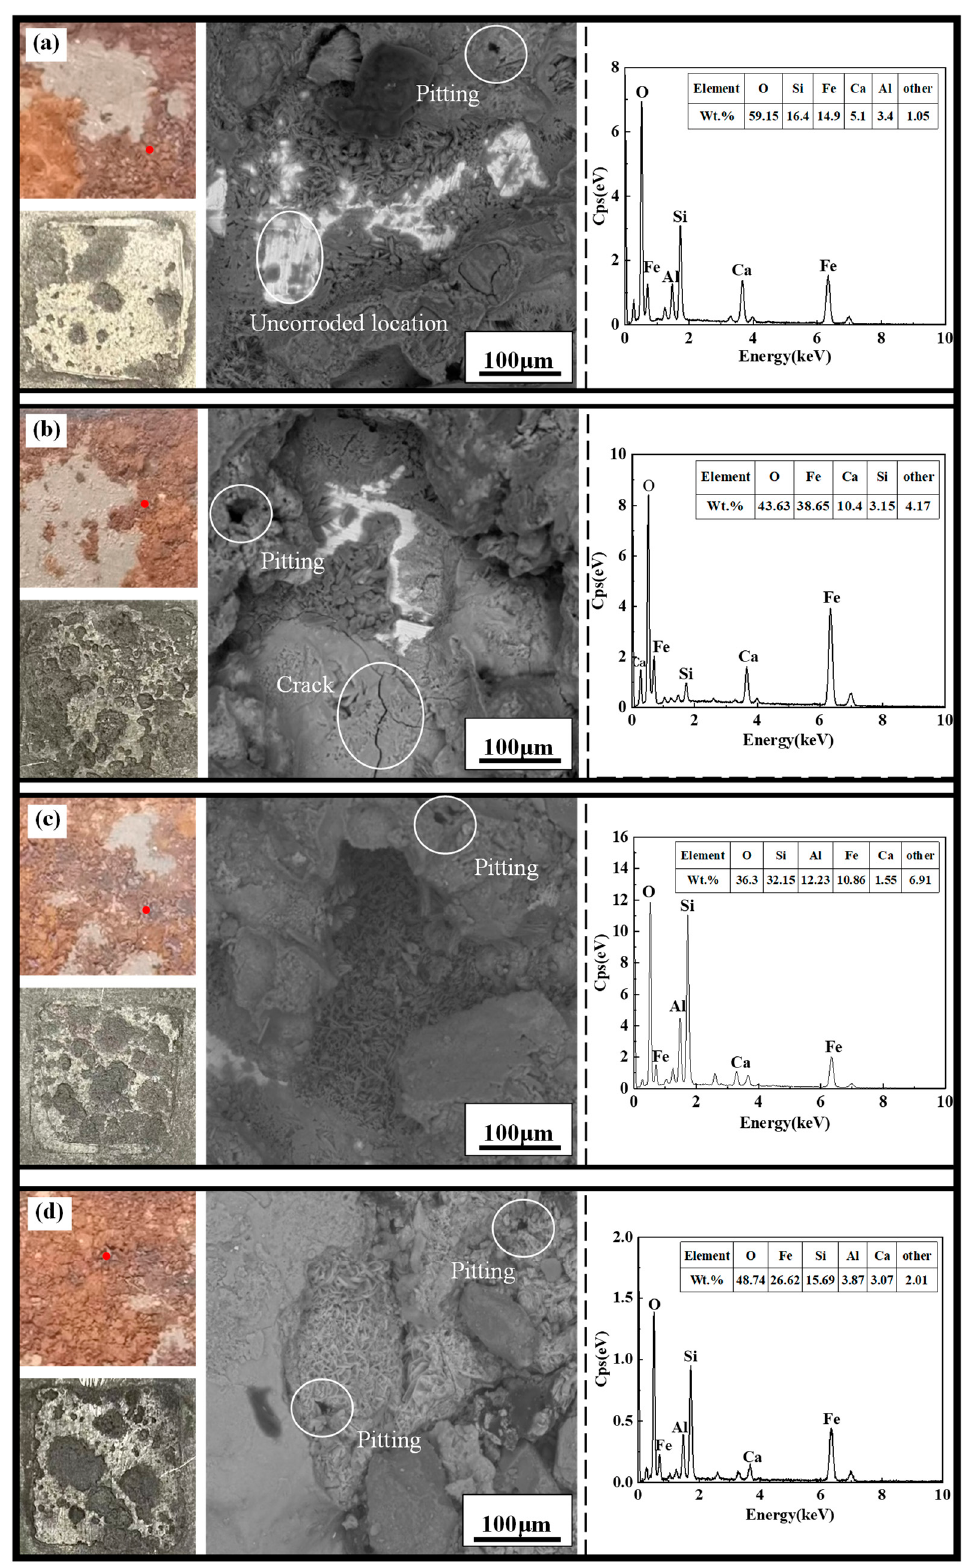
Figure 17. Macroscopic and microscopic corrosion morphology and elemental analysis results of X70 steel under capillary action in saline soils with a NaCl content of 0.3%: ( a ) 12 # , ( b ) 27 # , ( c ) 42 # , and ( d ) 57 #